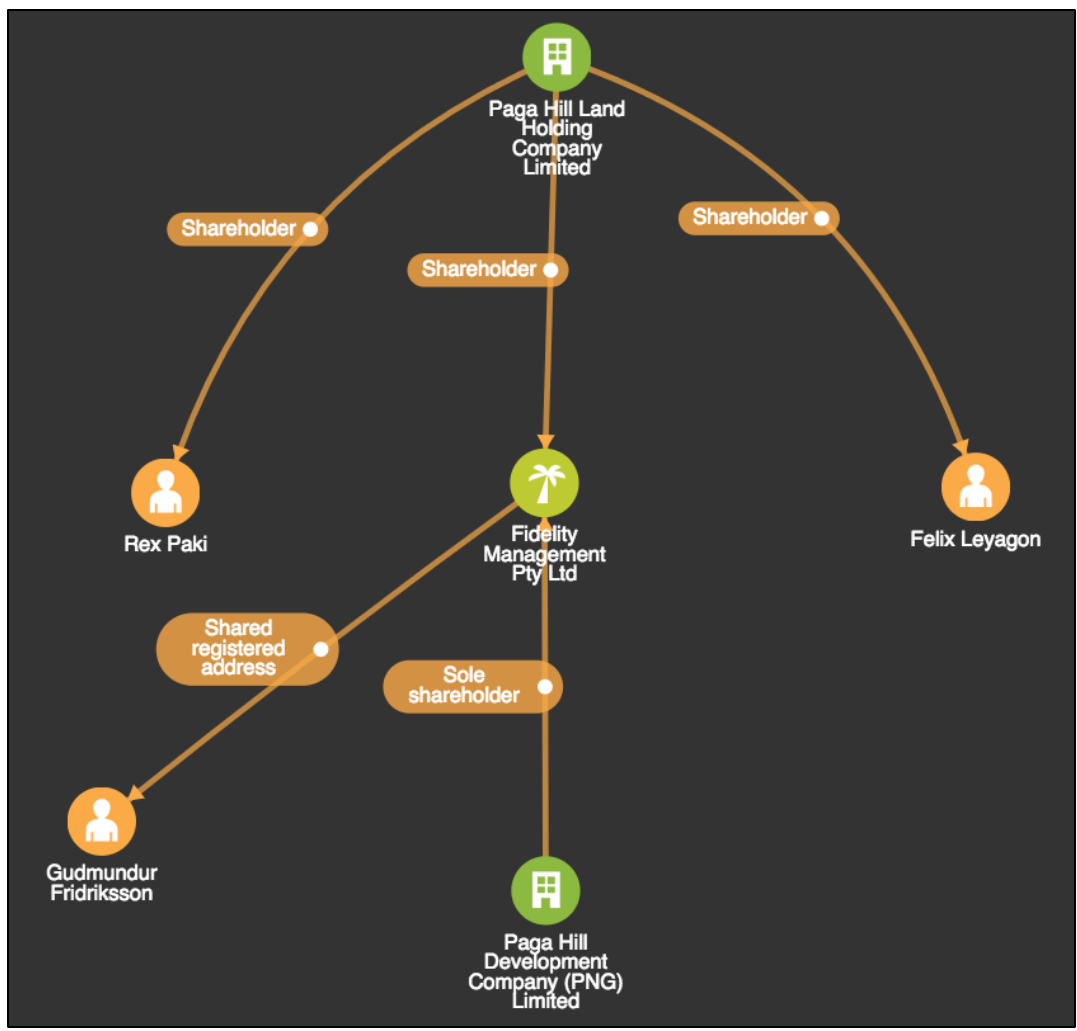
Diagram 3: The ownership structure of PHLHC and PHDC in the year 2000 Source: Investment Promotion